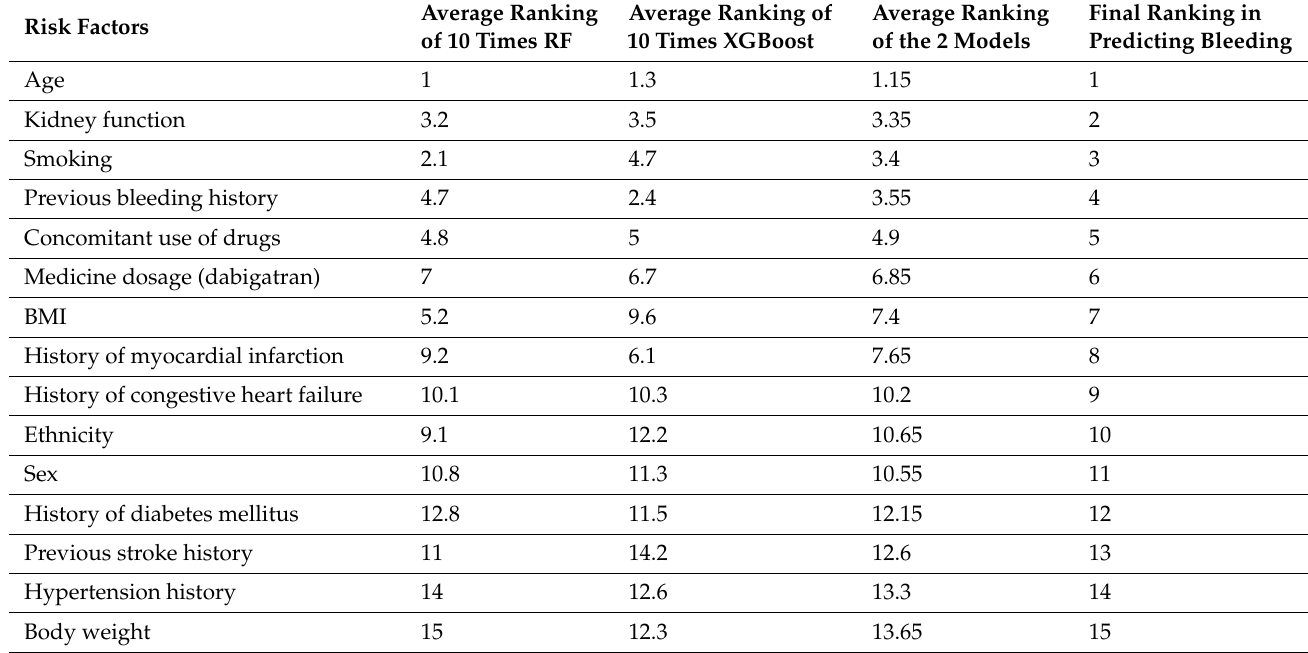
Table 6. Overall importance ranking of each risk factor in predicting bleeding based on RF and